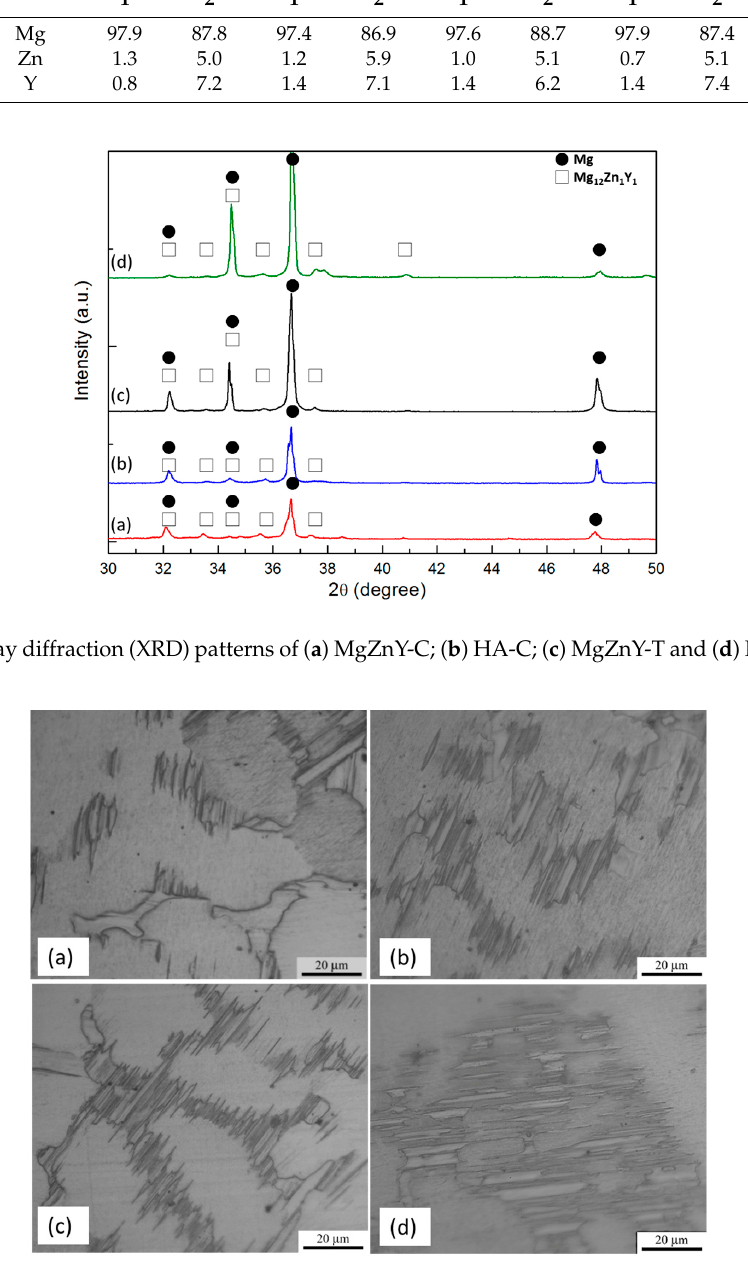
Table 1. Chemical composition of phases in the samples (at%).